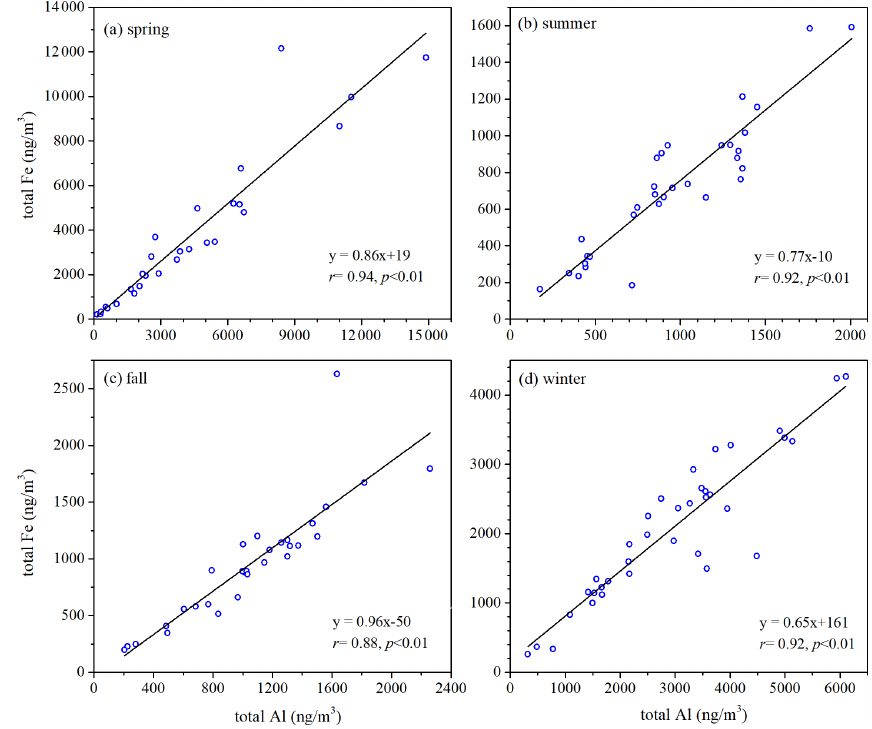
Figure 2. Total Fe versus total Al for fine particles in different seasons: (a) spring; (b) summer; (c) fall; (d) winter.